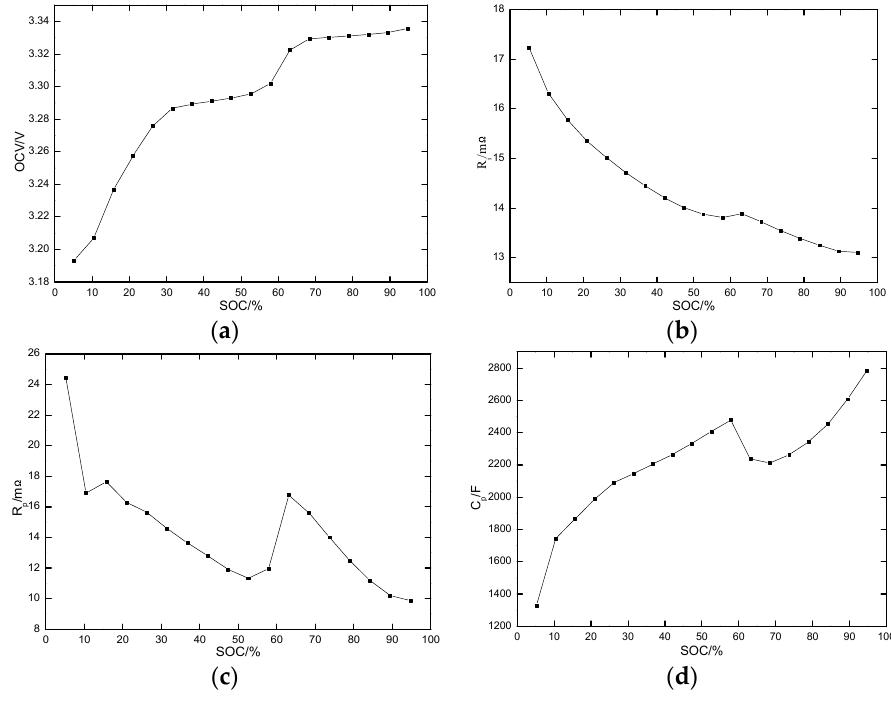
Figure 6. The parameters of a cell ( a ) OCV; ( b ) R